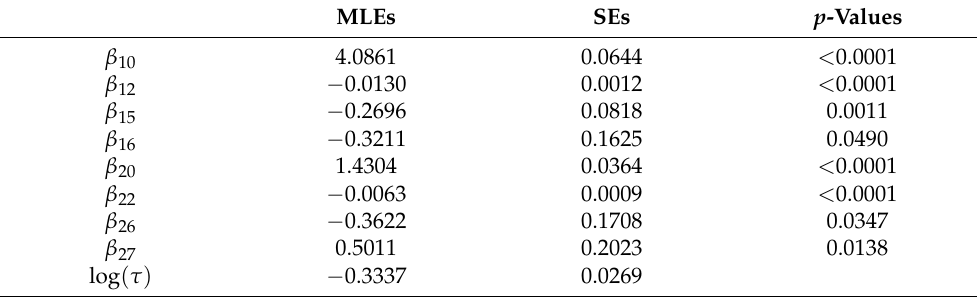
Table 5. Findings from the reduced OLLW regression